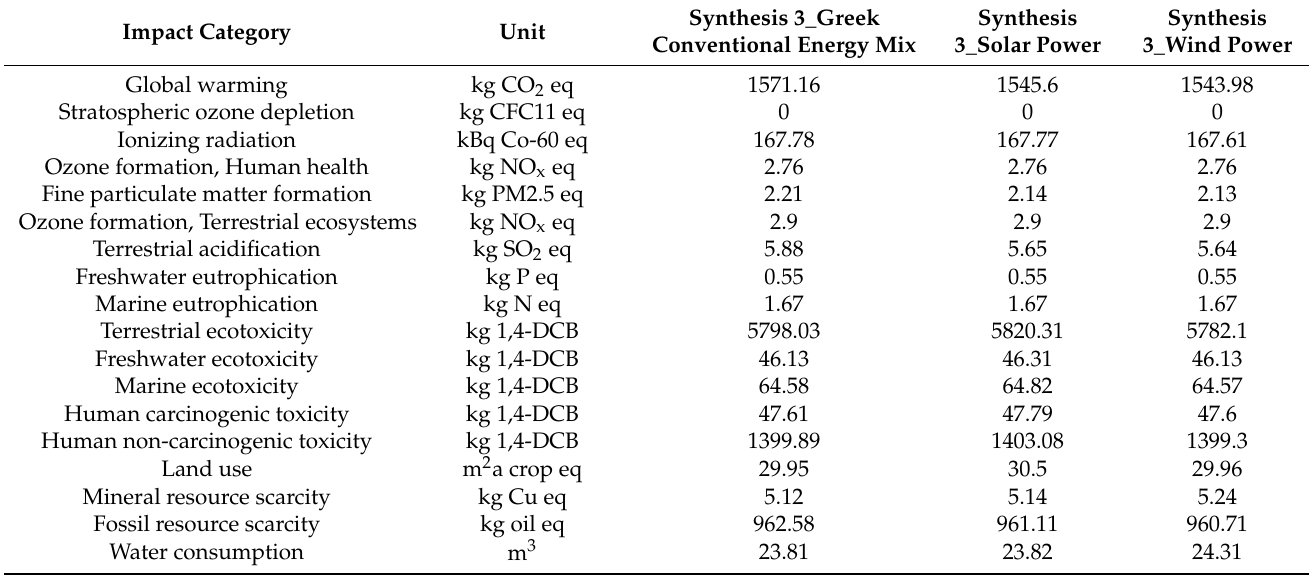
Table 3. Life Cycle Assessment sensitivity analysis on Synthesis 3 involving different energy